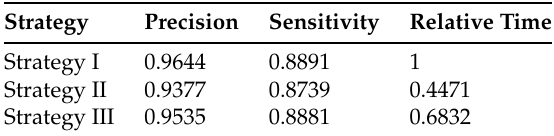
Table 7. Retraining Strategies I–III performance on Cargo dataset.